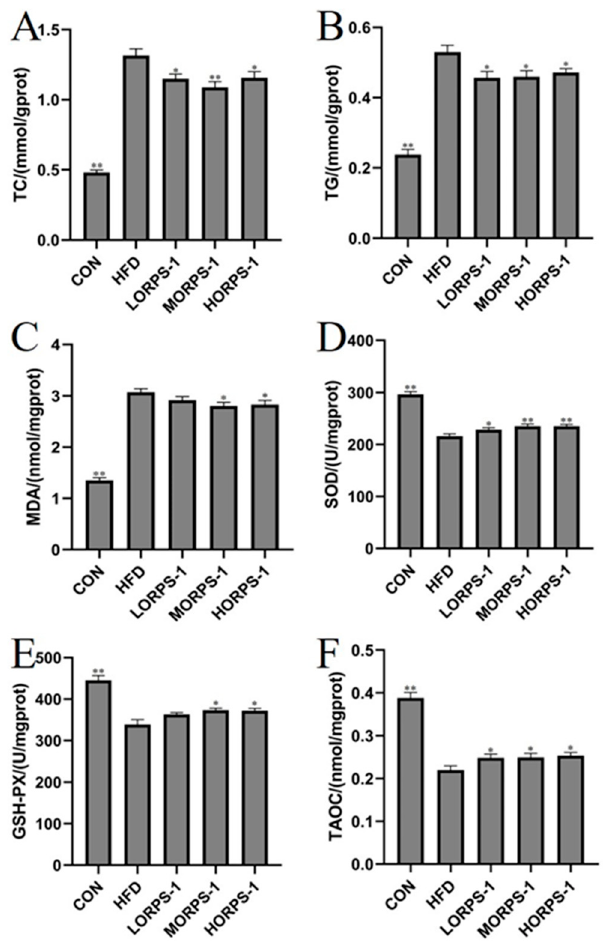
Figure 4. Effects of ORPS-1 (ORPS, Oudemansiella raphanipies polysaccharide) treatment on major hepatic indices in NAFLD mice. Effects of ORPS on liver metabolites. ( A ) TC, ( B ) TG, ( C ) MDA, ( D ) SOD, ( E ) GSH-PX, ( F ) TAOC. GSH-PX, glutathione peroxidase; MDA, malondialdehyde; TC, total cholesterol; TG, triglyceride; SOD, superoxide dismutase; TAOC, total antioxidative capacity. Values are expressed as the mean ± SD. * p < 0.05, vs. HFD group; ** p < 0.01, vs. HFD group. ( n = 10 mice/group).